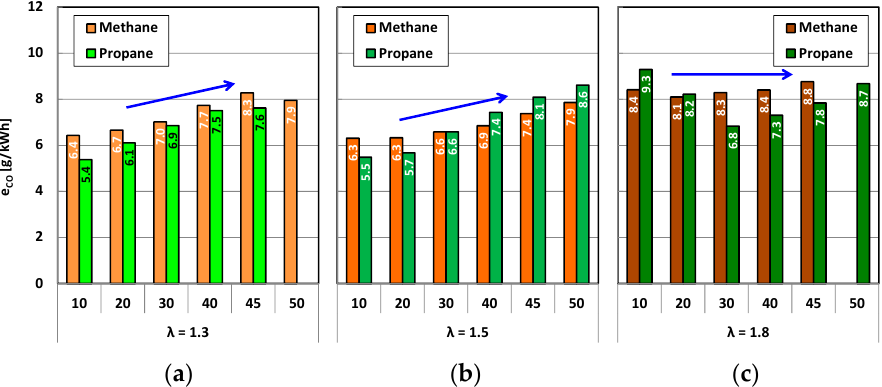
Figure 16. Carbon monoxide emissions at different values of energy supplied to the prechamber: ( a ) λ = 1.3; ( b ) λ = 1.5; and ( c ) λ = 1.8 (the arrows indicate the